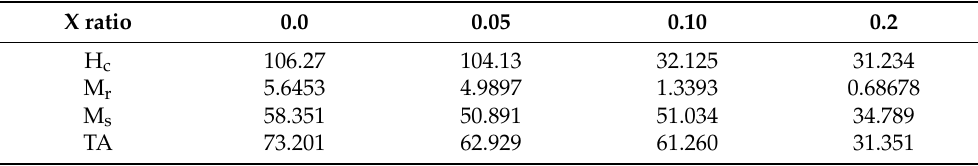
Figure 8. The change in Ms with change in V-doping level.